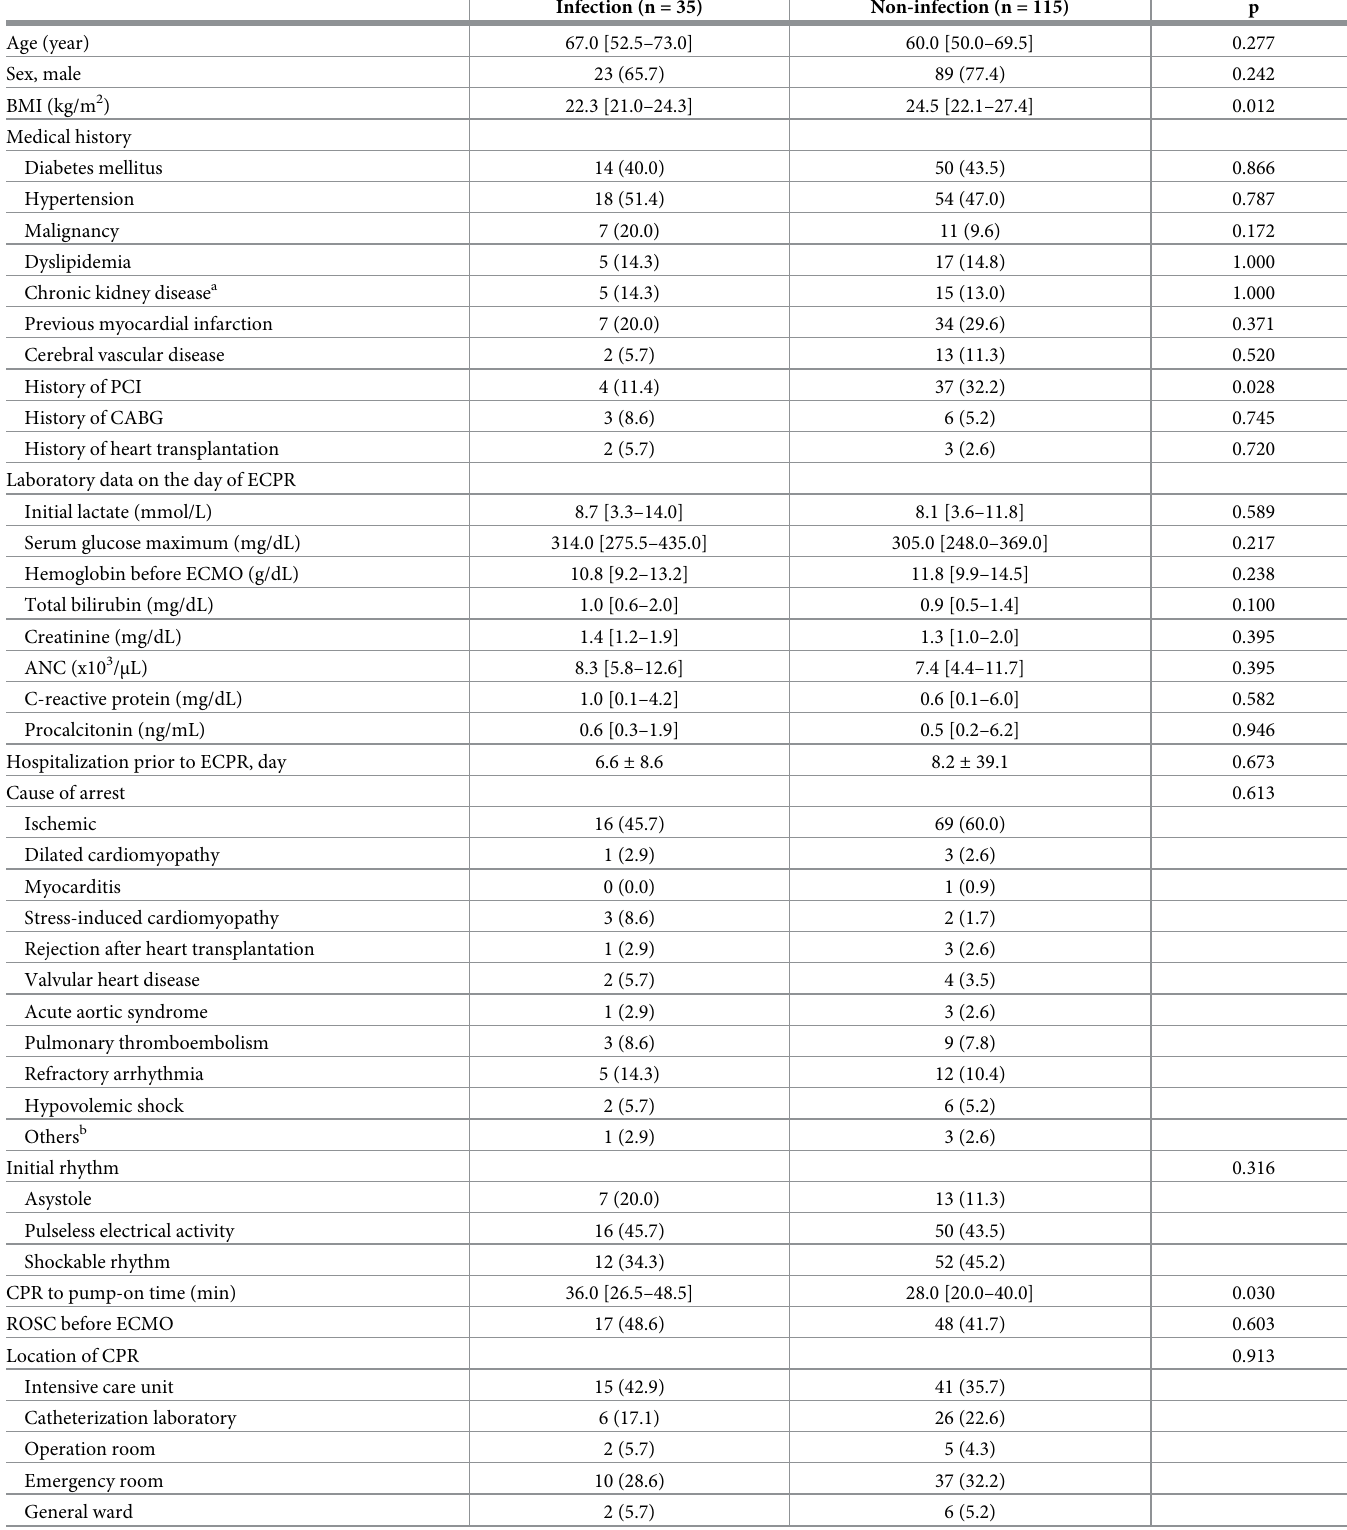
Table 1. Clinical characteristics and initial